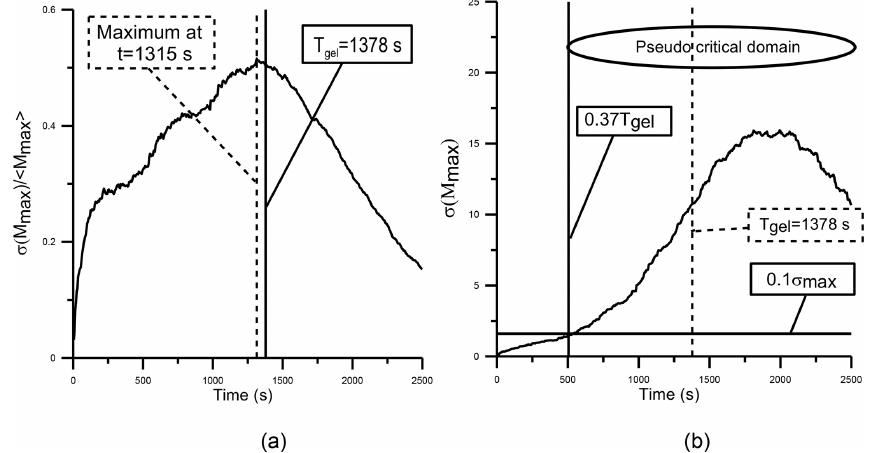
Figure 3. For the finite system, the normalized standard deviation σ(M max )/ (cid:104) M max (cid:105) of the largest droplet mass versus time (a) . The initial number of droplets was set equal to N = 100 droplets of 14µm in radius in a volume of 1cm 3 . Simulations were performed with the product kernel K(i,j) = Cx i x j (with C = 5 . 49 × 10 10 cm 3 g − 2 s − 1 ), and N r = 1000 realizations of the stochastic algorithm were performed. The maximum value of σ(M max )/ (cid:104) M max (cid:105) is found to be 1315s (dashed vertical line) and is very close to the sol–gel transition time (contin- uous vertical line) for the infinite system (1378s). In panel (b) the small end of the pseudo-critical domain is estimated as the time where σ(M max ) = 0 . 1 σ max .